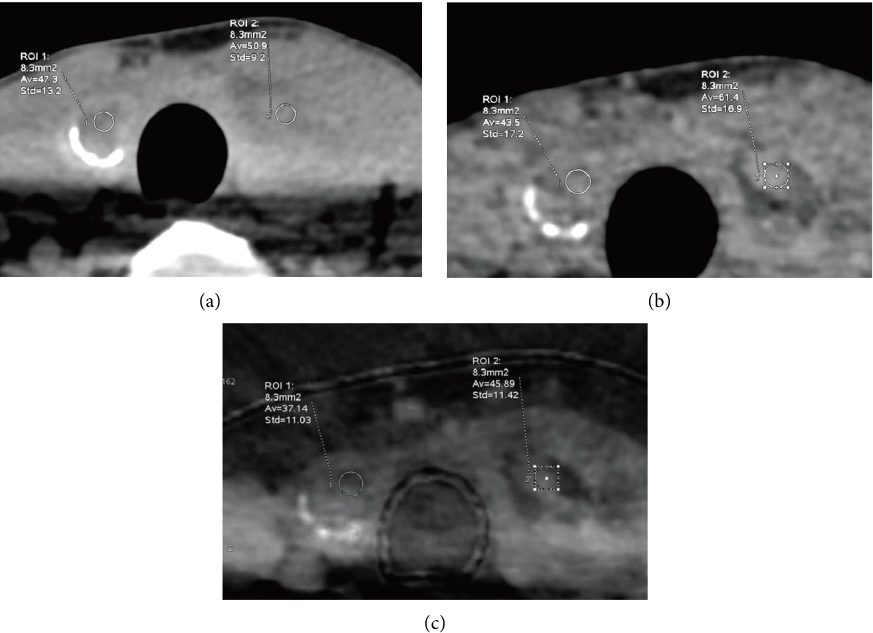
Figure 5: Axial true noncontrast (TNC) and venous-phase virtual noncontrast images (VNC) from a 44-year-old woman with papillary carcinoma (right side) and nodular goiter (left side). Te absolute attenuation between TNC (a) and VNC (b) images for papillary carcinoma (3.8HU) was smaller than that for nodular goiter (10.5HU). Te iodine density (c) of nodular goiter (left side) was higher than that of papillary carcinoma (right side) (45.89 vs. 37.14; cutof � 38.35).